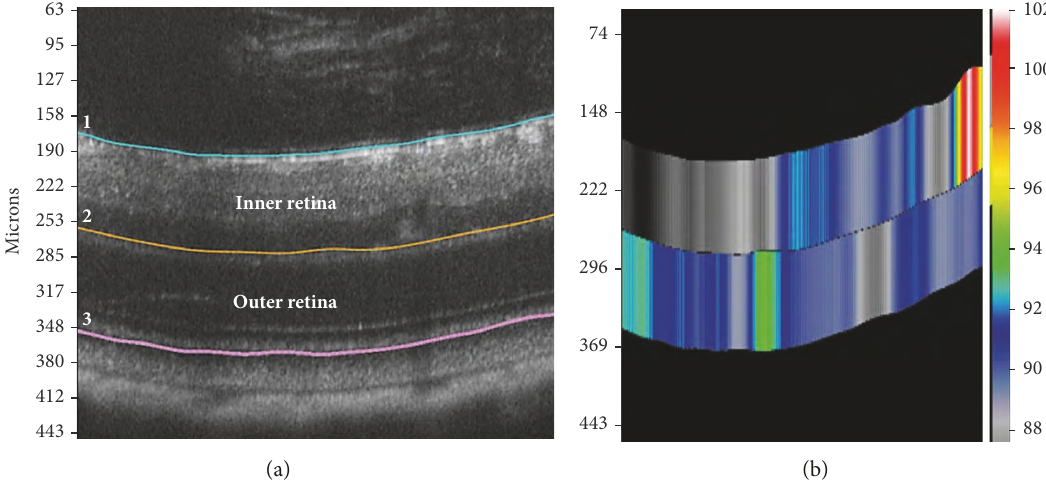
Figure 2: Spectral domain optical coherence tomography and corresponding thickness color map in P47 RA mouse. (a) Boundaries of the inner retina and outer retina. (b) Thickness color map for the SD-OCT generated from delineating the retinal boundaries. Line 1 was made at the superior boundary of inner limiting membrane (ILM). Line 2 was made at the lower edge of the IPL. Line 3 was made at the inferior boundary of the PRL. Lines 1 to 3: total retinal thickness is measured. Lines 1 to 2: inner retinal thickness is measured. Lines 2 to 3: outer retinal thickness is measured. Note: SD-OCT refers to spectral domain optical coherence tomography. Lines refer to linear segmentation